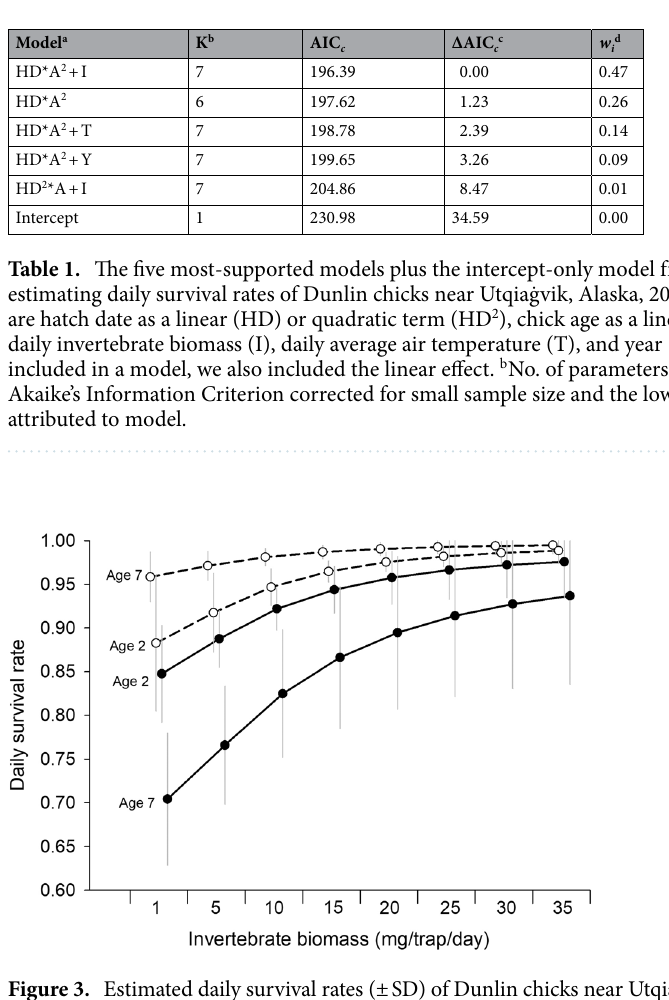
Figure 3. Estimated daily survival rates (± SD) of Dunlin chicks near Utqiaġvik, Alaska, 2008–2009 as a function of invertebrate biomass for chick ages (2 and 7 days) and average hatch date for initial (3 July, dashed lines and open circles) and replacement (15 July, solid lines and closed circles) nests. Daily survival rates and associated SDs were estimated using 10,000 simulations of the beta estimates assuming a multivariate normal distribution and the variance–covariance matrix from the top-ranked model (HD*A 2 + I; where HD = hatch date, A = chick age, and I = daily invertebrate biomass; Table 1). Symbol locations represent the same invertebrate abundance at each combination of hatch date and age, but symbols are offset so SDs are